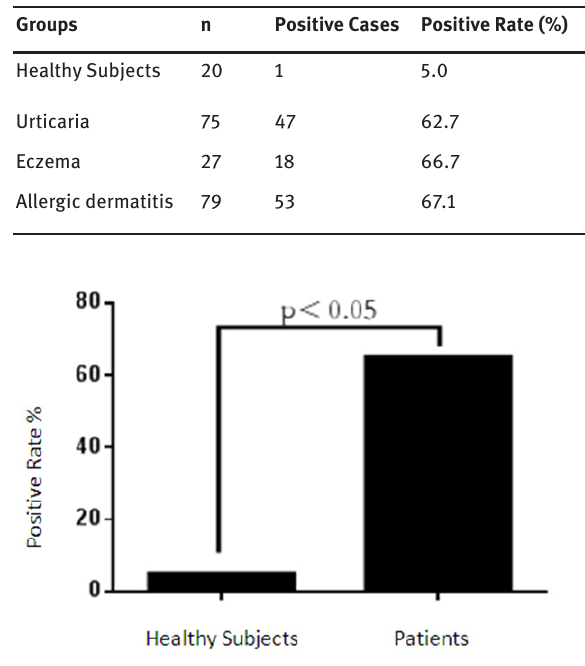
Table 2: Comparison of IgG antibody positive rate between healthy group and allergy dermatosis